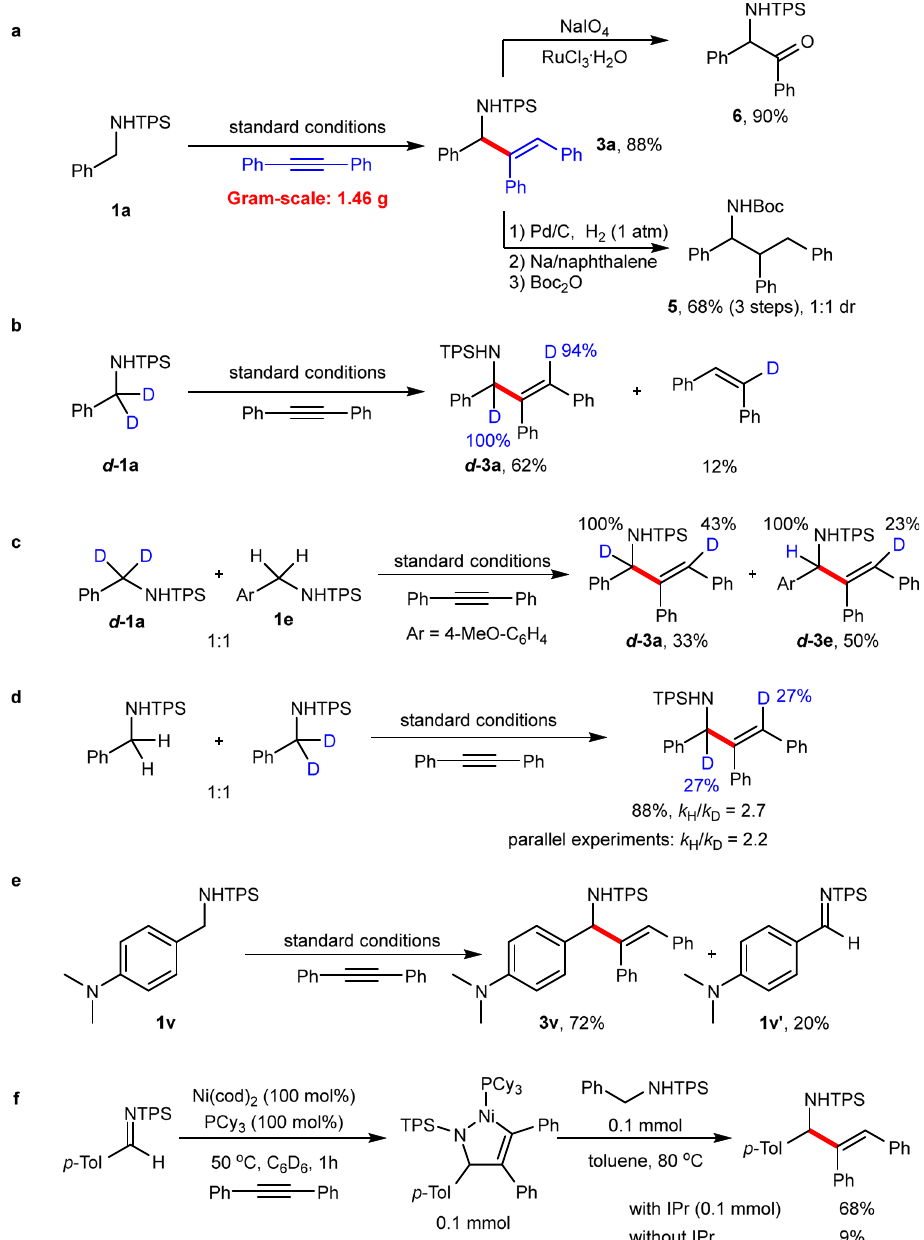
Fig. 5 Synthetic utility and mechanistic experiments. a Gram-scale reaction and product transformation. b Deuterium labeling experiments. c Intermolecular competition. d Determination of kinetic isotope effect. e Detection of imine. f Stoichiometric